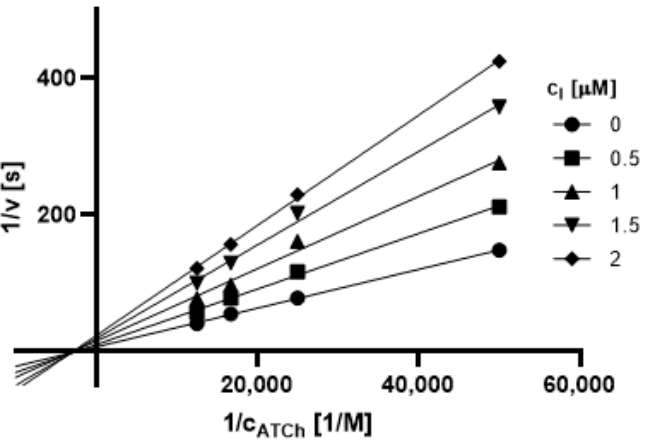
Figure 9. Lineweaver–Burk plot for 1p and AChE inhibition (ATCh = acetylthiocholine).